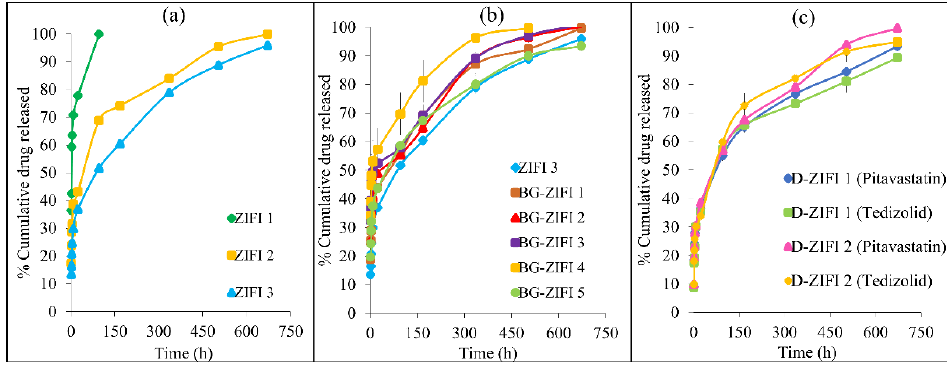
Figure 3. In vitro release profiles of pitavastatin from formulations ( a ) ZIFI 1, 2, and 3.( b ) BG-ZIFI 1, 2, 3, 4, and 5, in comparison with ZIFI 3. ( c ) In vitro release profiles of pitavastatin and tedizolid from D-ZIFI 1 and D-ZIFI 2. D-ZIFI 1 and D-ZIFI